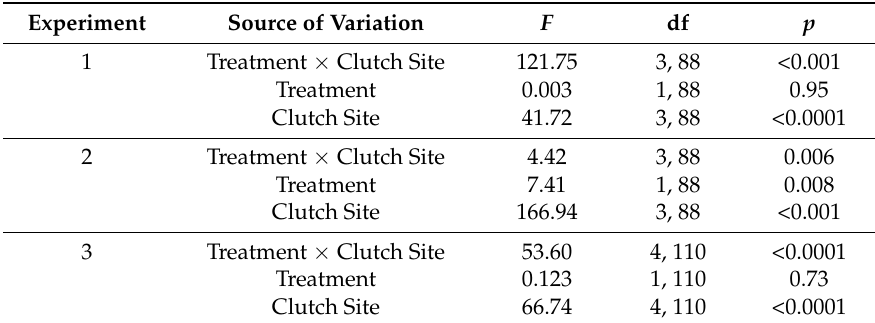
Table 1. Two-way analysis of variance (ANOVA) statistics of the interaction between treatments and clutch site selection by C . maculata females in solitary 1 cages.